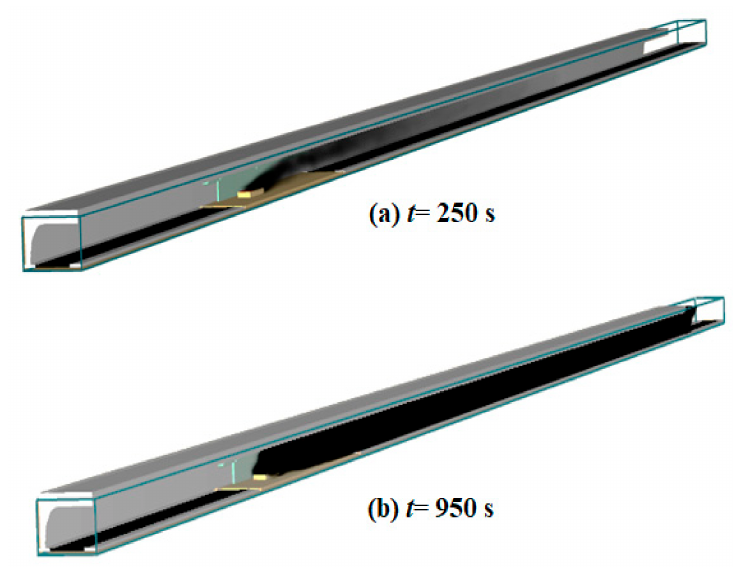
Figure 10. Contour plots of soot yield at ( a ) t = 250 and ( b ) 950